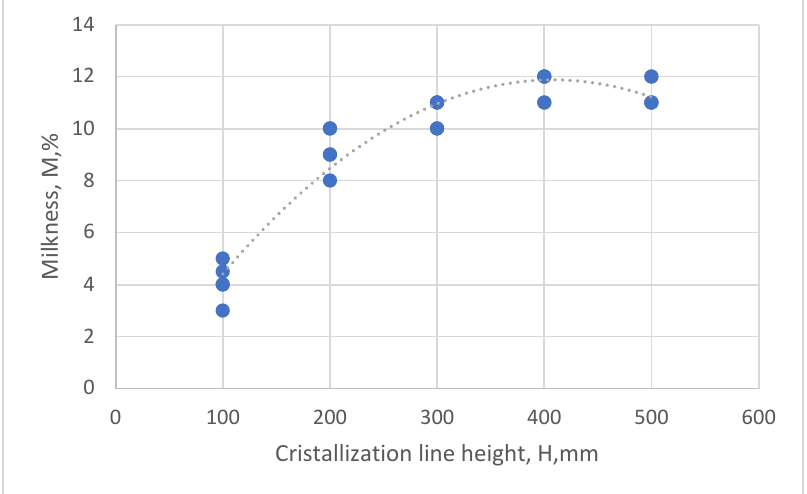
Figure 17. Influence of the crystallization line height on the milkness.